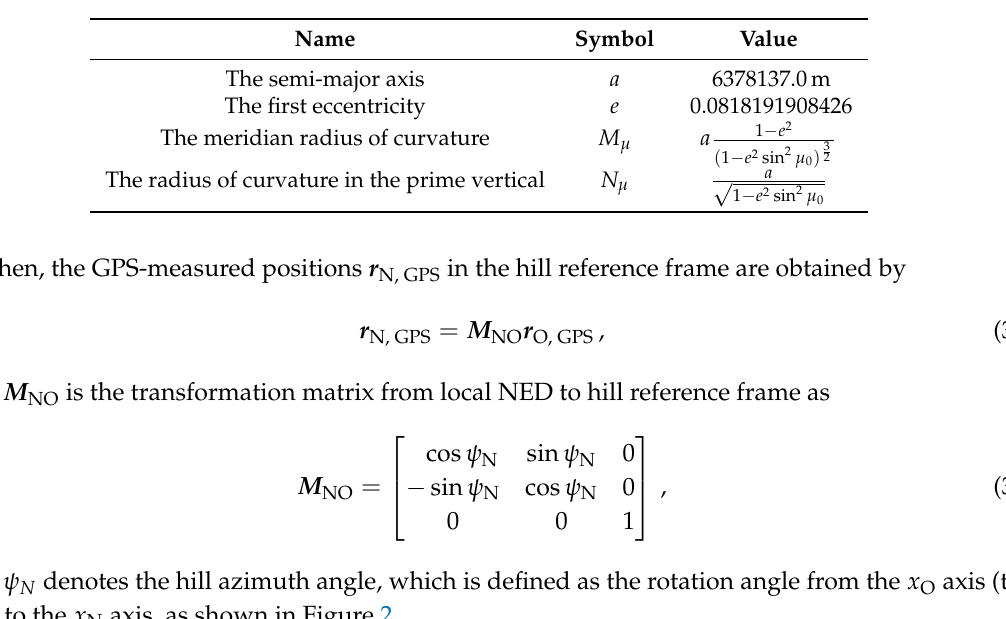
Table 2. Parameters for the WGS84 reference